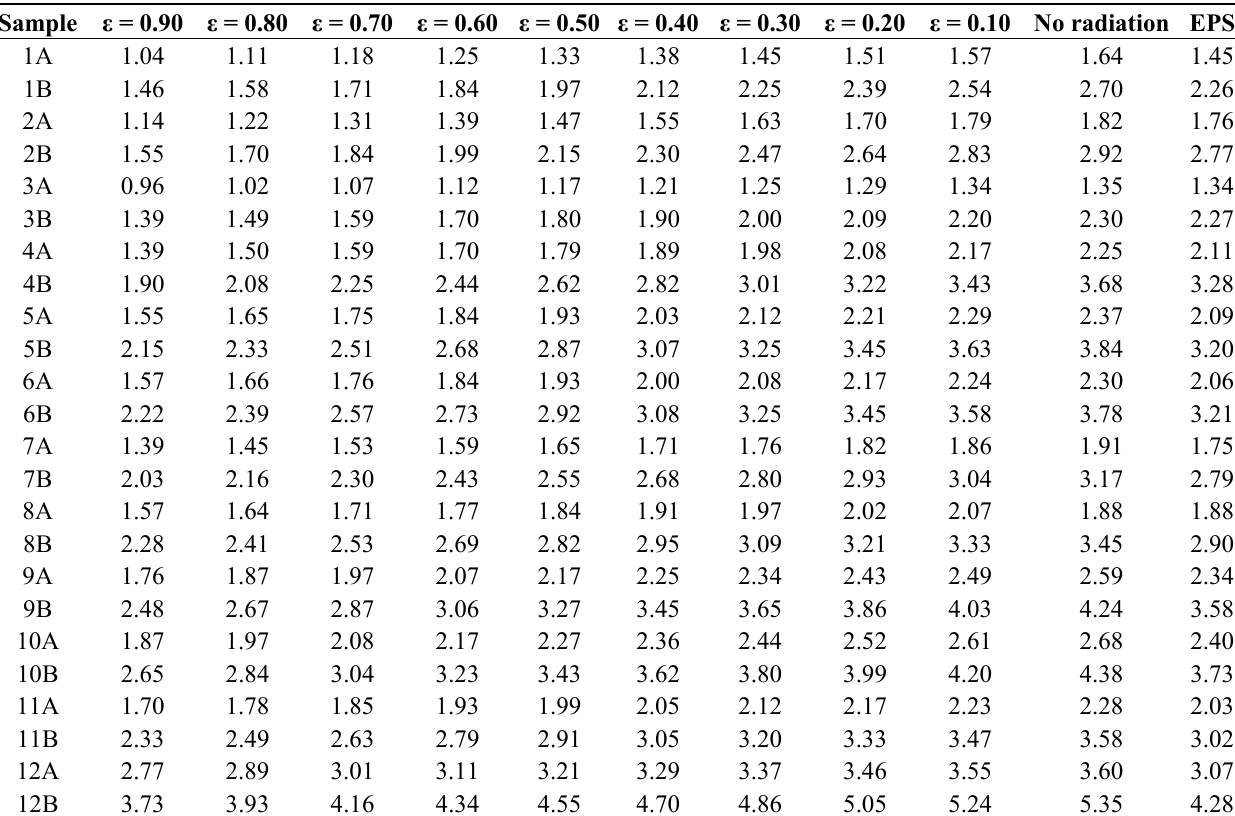
Table 4. Thermal resistance of the evaluated block (m 2 ·K/W).